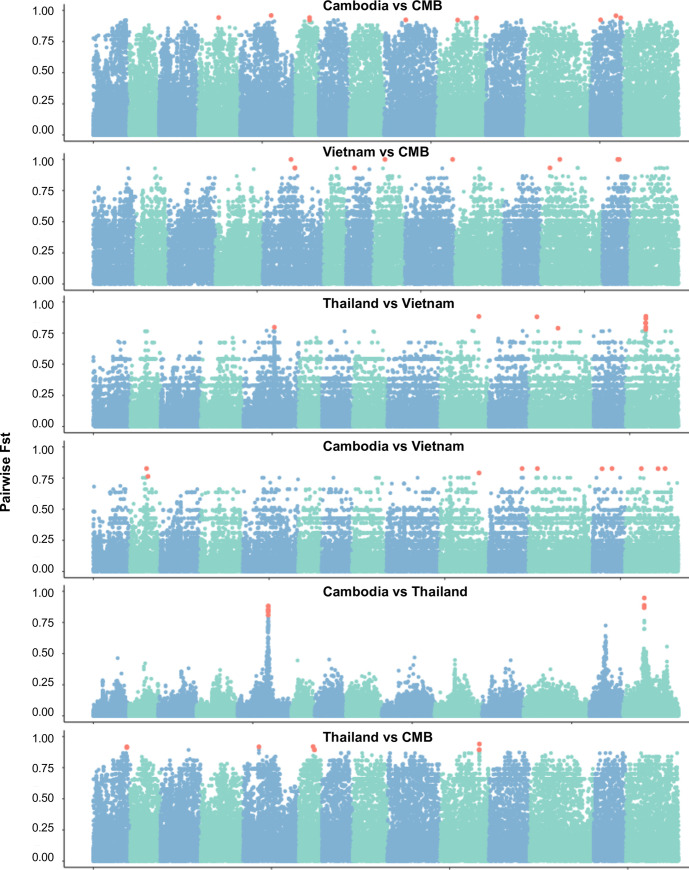
FST values across the genome for each pairwise comparison.Each blue or green section is a subsequent chromosome, with each point being a separate core SNP. Salmon-colored SNPs represent the top 10 SNPs from each pairwise comparison.